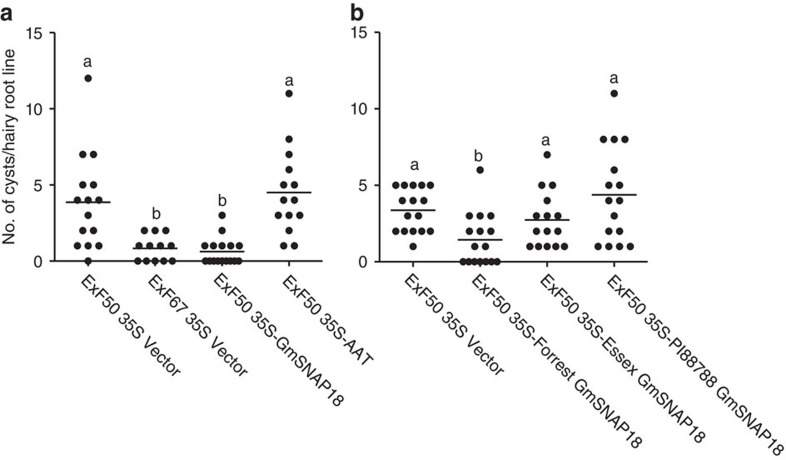
SCN infection of transgenic hairy roots of ExF50 expressing GmSNAP18 or AAT.(a) SCN infection of RIL ExF50 transgenic hairy roots expressing Forrest GmSNAP18 or AAT. Vector-transformed ExF50 (SCN-susceptible) and ExF67 (SCN-resistant) hairy roots were used as controls. Each dot represents the number of cysts on a single hairy root line. The number of dots corresponds to the number of independent hairy root lines used. Mean values significantly different from the control were determined using an unpaired t-test (P<0.0004) and are denoted by different letters. Similar results were obtained from at least five independent experiments with Forrest GmSNAP18 and at least two independent experiments with AAT. Data from one representative experiment are shown. (b) SCN infection of RIL ExF50 transgenic hairy roots expressing GmSNAP18 of Forrest, Essex or PI 88788. Vector-transformed ExF50 (SCN-susceptible) hairy roots were used as a control. Each dot represents the number of cysts on a single hairy root line. The number of dots corresponds to the number of independent hairy root lines used. Mean values significantly different from the control were determined using an unpaired t-test (P<0.0015) and are denoted by different letters. Similar results were obtained from at least three independent experiments. Data from one representative experiment are shown.